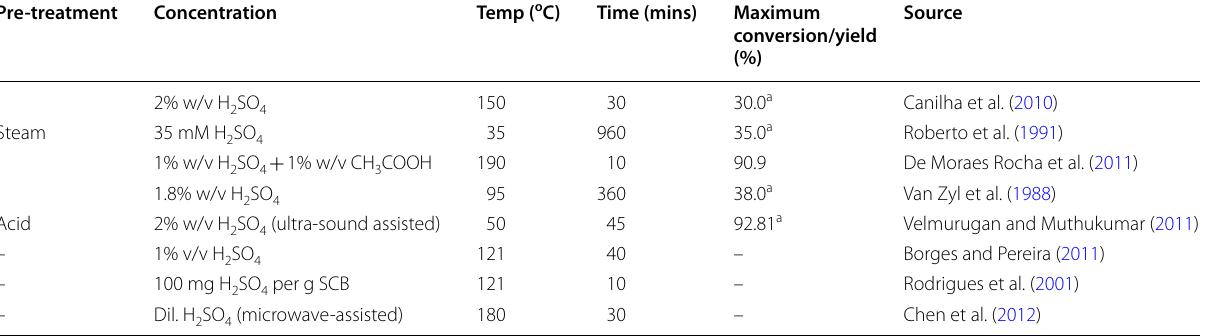
a Optimum yield of ethanol from fermentation